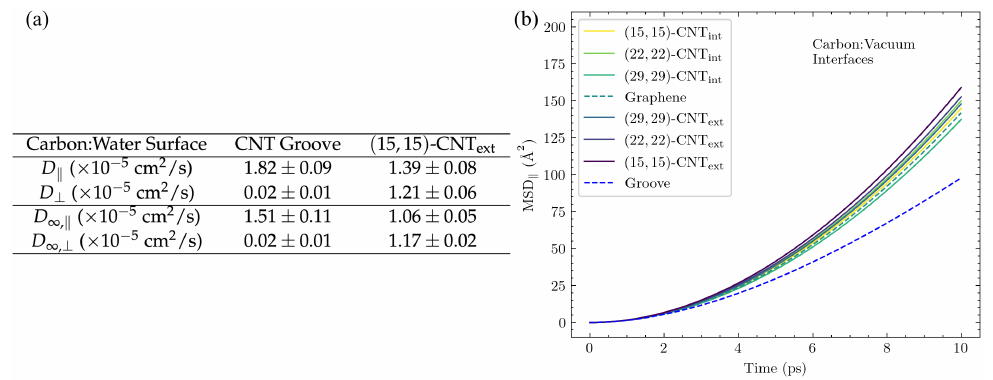
Figure 13. Diffusion coefficients of DA within a CNT groove. The CNT groove is constructed of two 100 Å long, aligned, ( 15,15 ) -CNTs. ( a ) Diffusion constants for the solvated CNT groove and a solvated ( 15,15 ) -CNT ext surface are shown here, both from the 100 Å simulation directly (top rows) and from the infinite-system size extrapolation (bottom rows). D (cid:107) is the 1D diffusion coefficient for motion along the CNT groove and axis, and D ⊥ is the 1D diffusion coefficient around the CNT circumference. ( b ) The axial mean squared displacement of DA is plotted for various surfaces at the carbon:vacuum interface. These MSD results are taken directly from simulations done in the vacuum on 100 Å CNTs and 100 × 100 Å 2